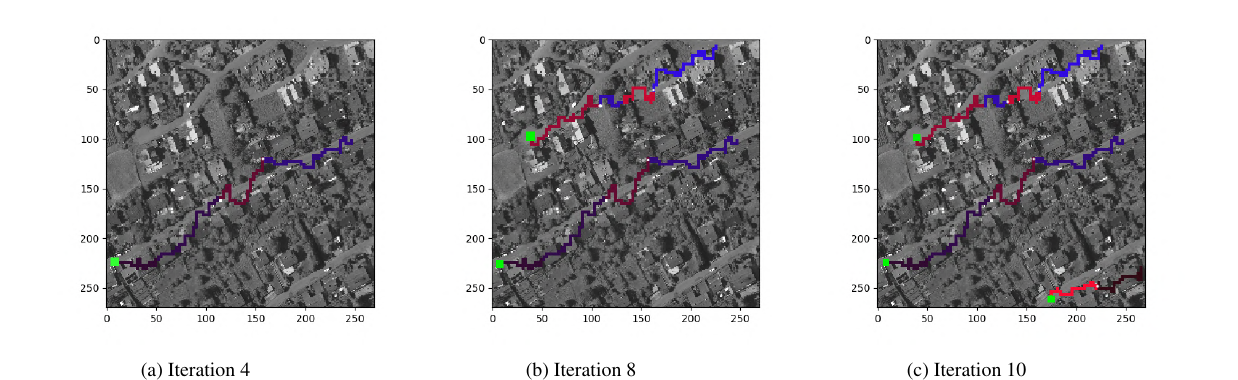
Figure 7. Hybrid approach on an unseen image. The starting seeds are highlighted in green (root seeds) and in white (last positions seed). The trajectories generated by the RL-agent at each iteration are highlighted with different colors.